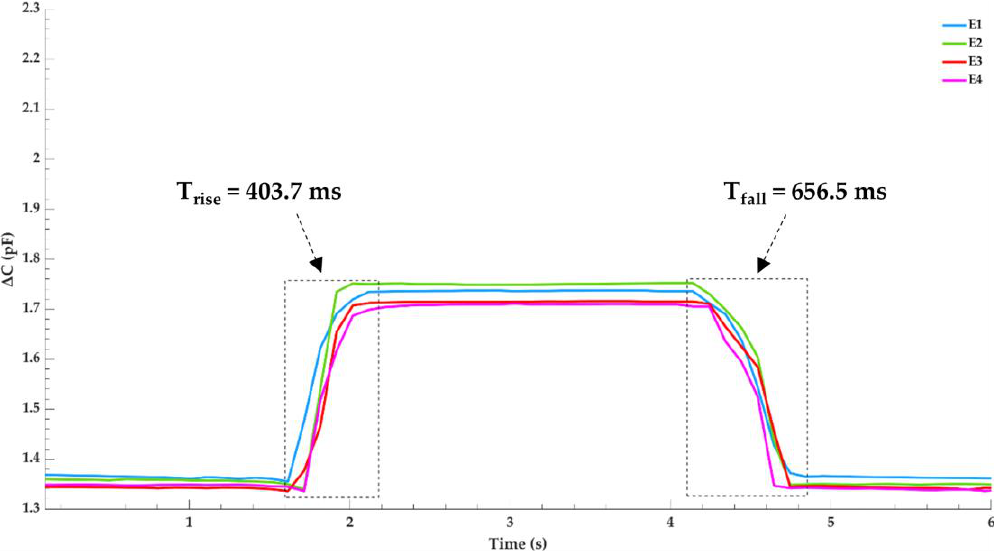
Figure 4. Pressure response and relaxation time of the sensor when a 14.13 kPa precision weight is quickly loaded and unloaded.